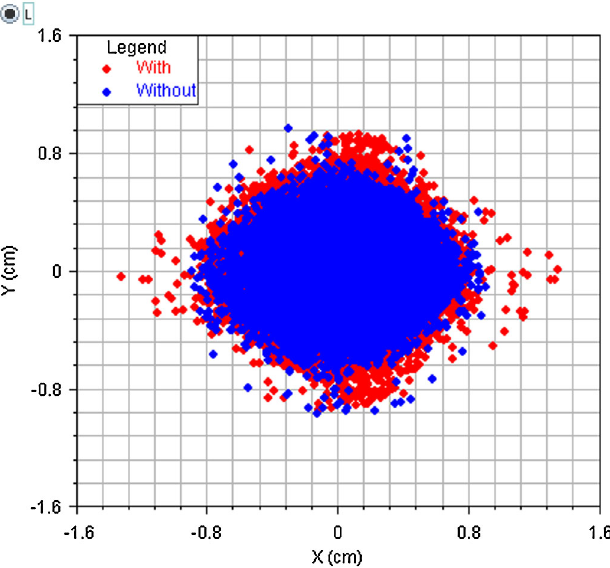
FIG. 7. (Color) Transverse beam profile at the SCL dummy section, for the design linac and the 38 mA design beams, with and without dodecapole components in the linac quadru- poles.